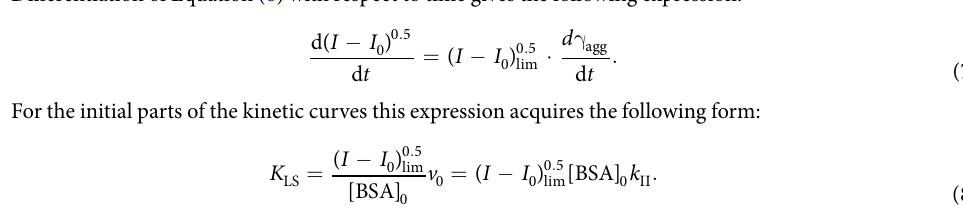
The coefficient of proportionality − . I I (